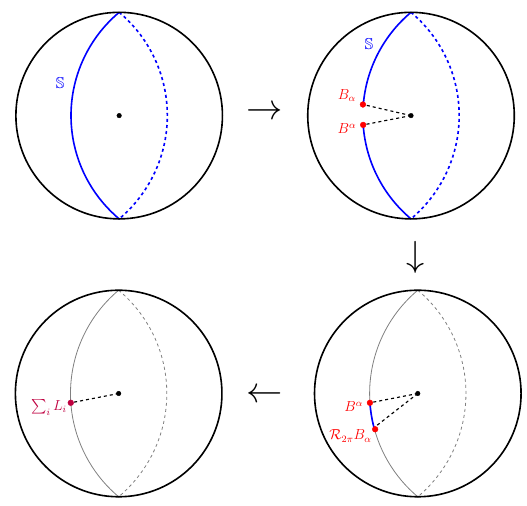
Figure 1 . The unwrapping process of a surface defect to a sum of lines. Starting in the upper left we have a surface defect S (shown in blue) wrapping an equator in S 3 as well as the S 1 which is not shown. The defect is cut open using a resolution of the identity with left and right boundary condi- tions B (cid:11) and B (cid:11) . The boundary conditions are then parallel transported around the equator using the operator . When they collide the surface defect is gone and a sum of line defects L i remains. R 2 (cid:25) where the c ( q ) are coe(cid:14)cients de(cid:12)ned in the unwrapping process. Moreover using j